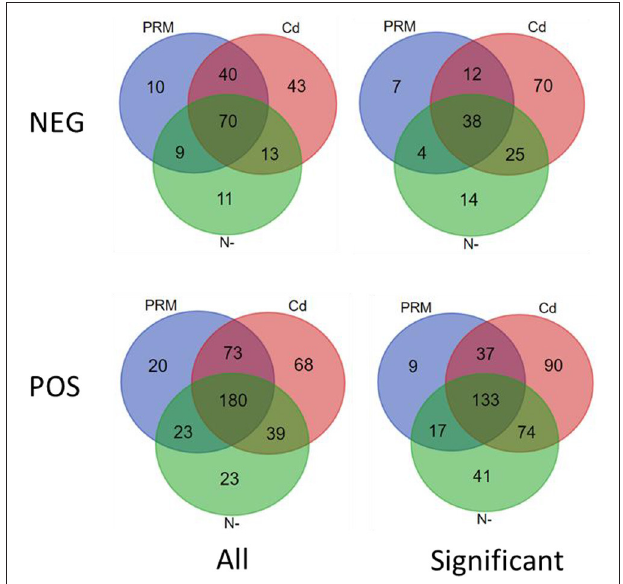
FIGURE 2 | Venn diagram of all (All) and significantly changed (significant) metabolites under stresses (PRM, paromomycin; Cd, CdCl 2 ; N–, nitrogen deprivation), under negative (NEG) and positive (POS) ion modes.